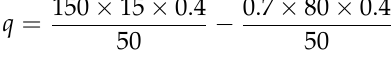
Table 6. Parameters of densities of the system of treatment.